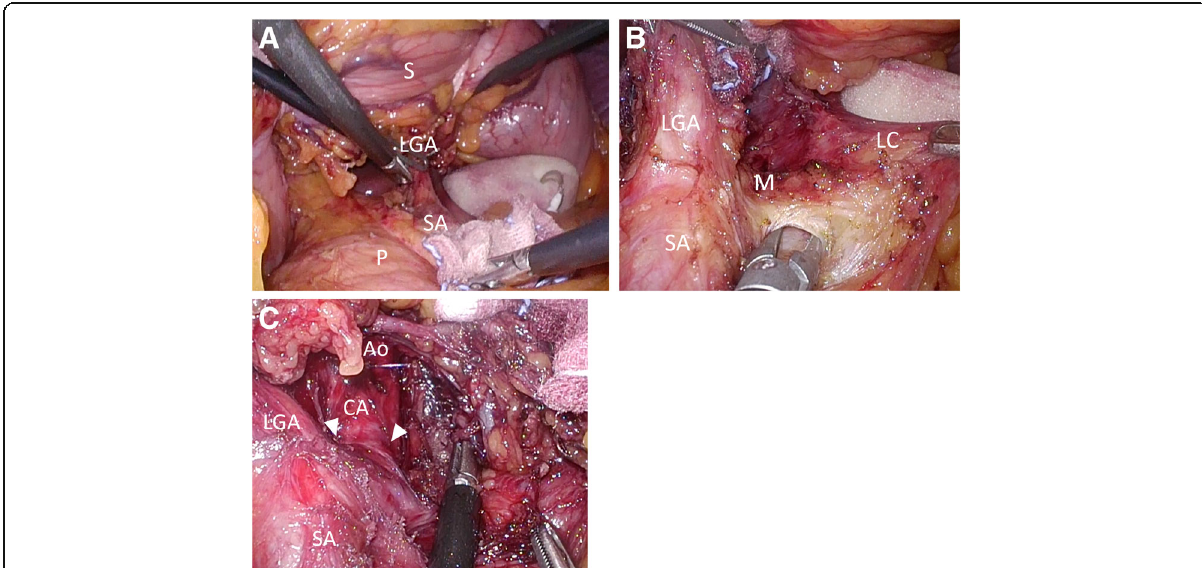
Fig. 2 a Intraoperative image showing horizontal approach with retracting the stomach ventrally. S, stomach; P, pancreas; LGA, left gastric artery; SA, splenic artery. b Intraoperative image showing the fibers of the MAL. M, MAL; LGA, left gastric artery; SA, splenic artery; LC, left crus. c Intraoperative image showing the origin of the celiac artery freed from the MAL (arrow head). Ao, arota; CA, celiac artery; LGA, left gastric artery; SA, splenic artery